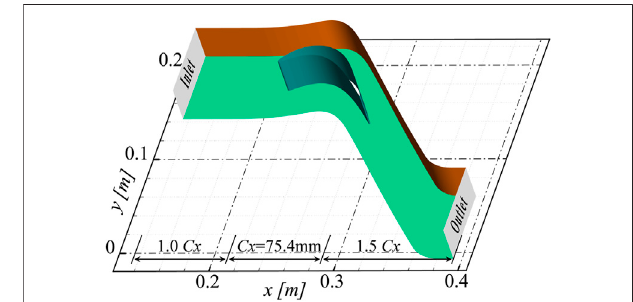
FIGURE 2 | Schematic of the computational domain.